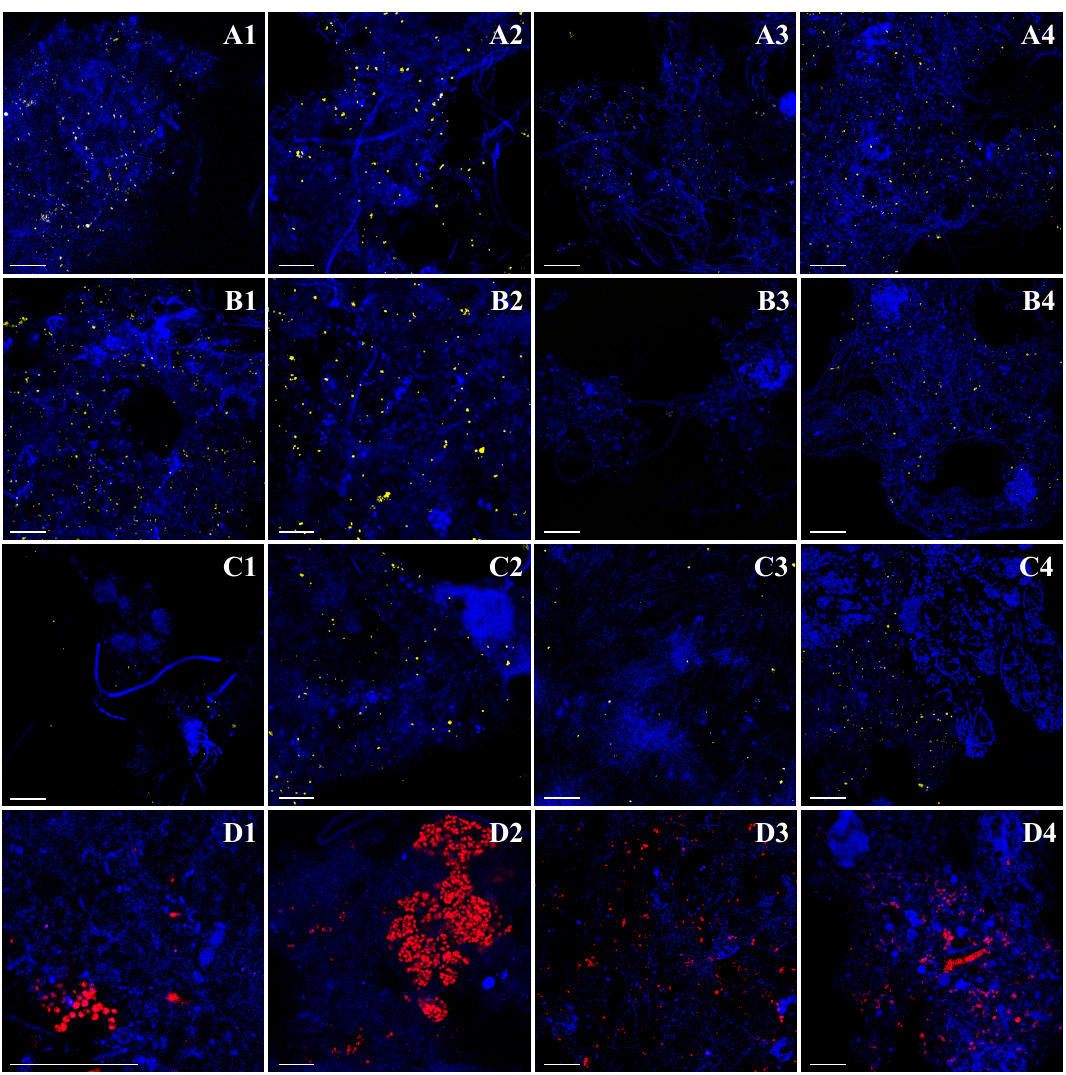
Figure 3. CLSM images showing morphology and spatial organization of AS containing ( A ) AOB (yellow), ( B ) Nitrobacter spp. NOB (yellow), ( C ) Nitrospira spp. NOB (yellow), and ( D ) PAOs (red), along with total eubacteria (blue). Shown here are (1) unseparated TMWRF sludge, (2) TMWRF sludge fraction with the best enrichment e ff ects (denser than 1.036 g / cm 3 ), (3) unseparated STMWRF sludge, (4) STMWRF sludge fraction with the best enrichment e ff ects (lighter than 1.030 g / cm 3 ). Scale bar indicates 20 μ m.